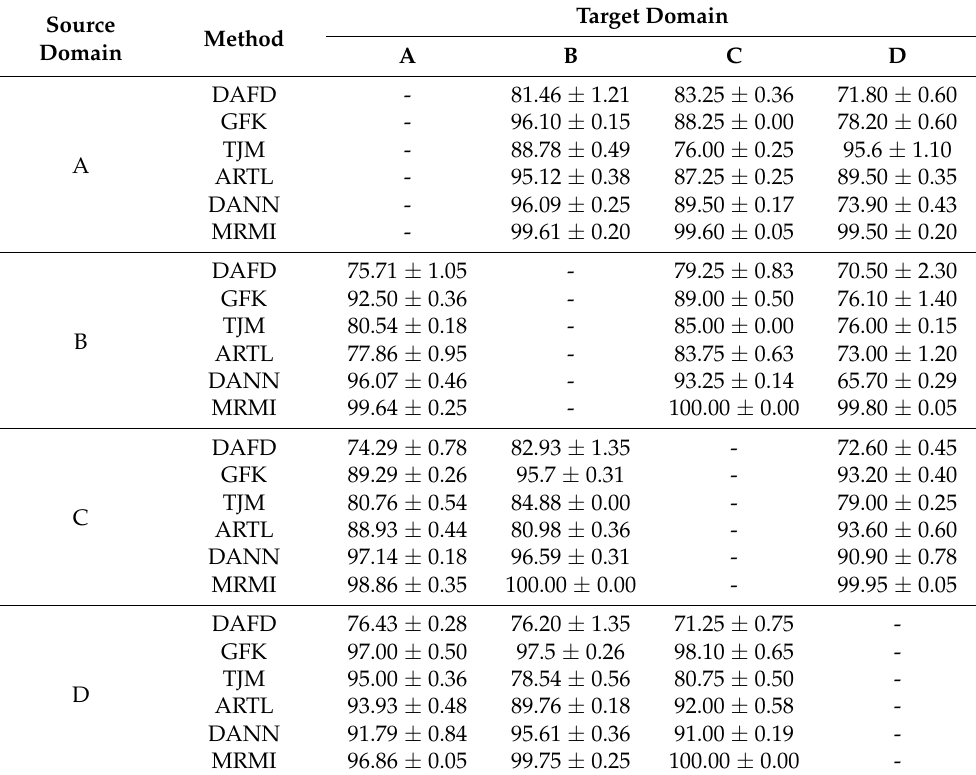
Table 3. The classification results (%) on class imbalanced rolling bearing